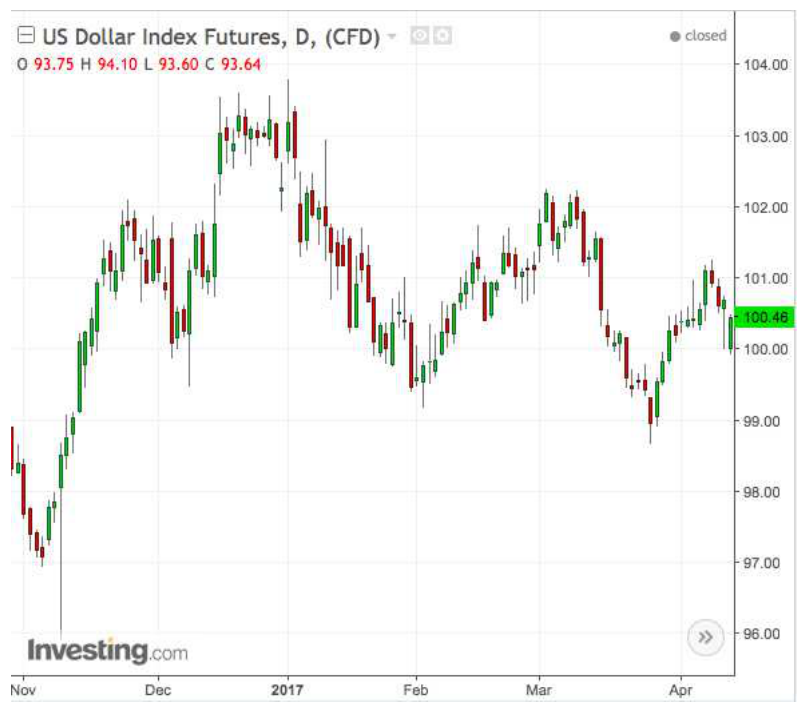
Figure 5. Dynamics of the dollar index from November 2016 to April